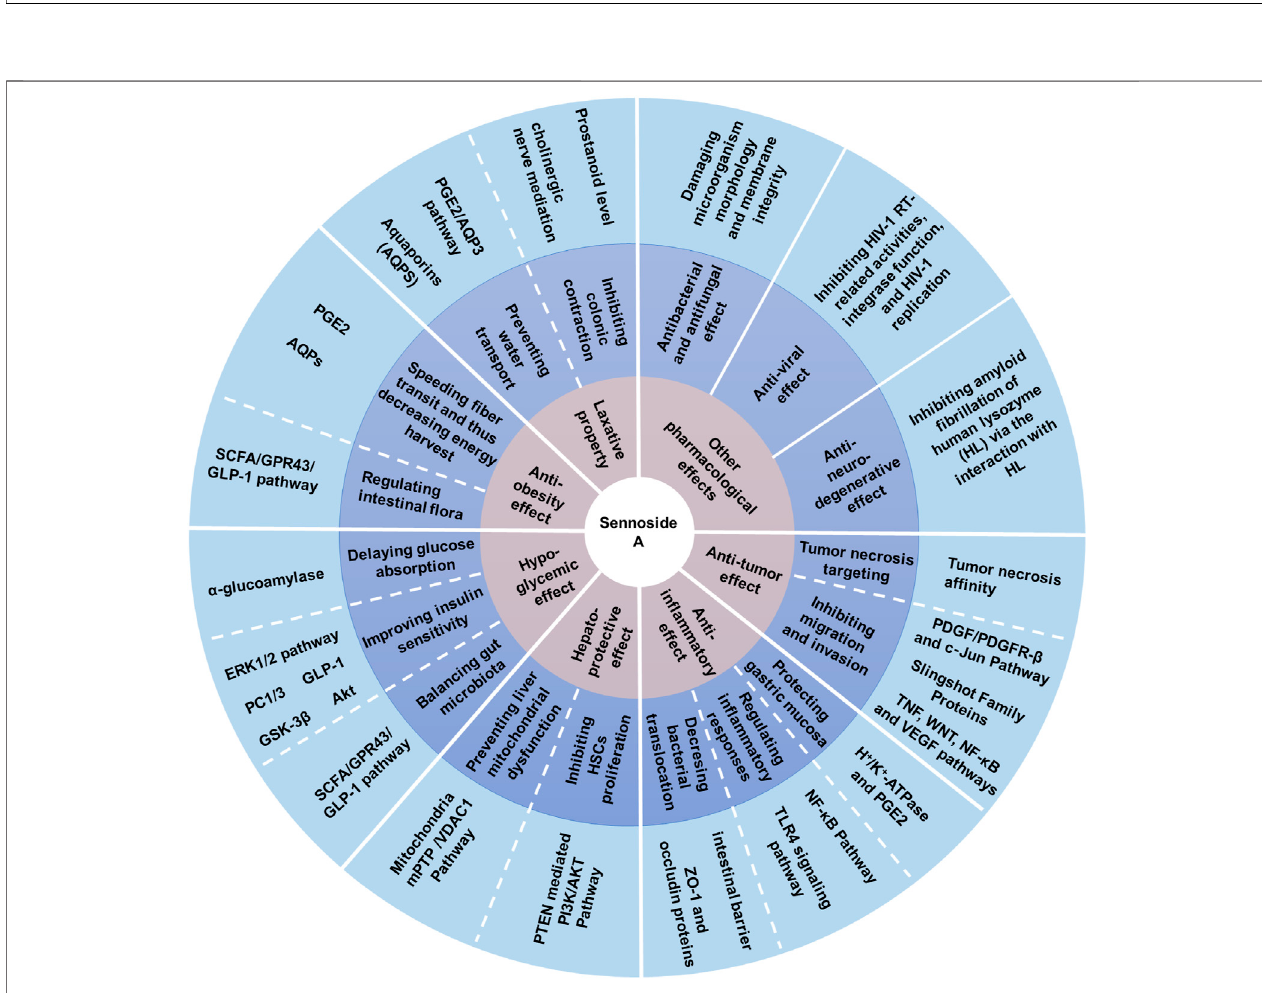
FIGURE 2 | Pharmacological activities of sennoside A. SA has many potential pharmacological bene fi ts, including laxative, anti-obesity, hypoglycemic, hepatoprotective, anti-in fl ammatory, anti-tumor, anti-bacterial, antifungal, anti-viral and anti-neurodegenerative effects.